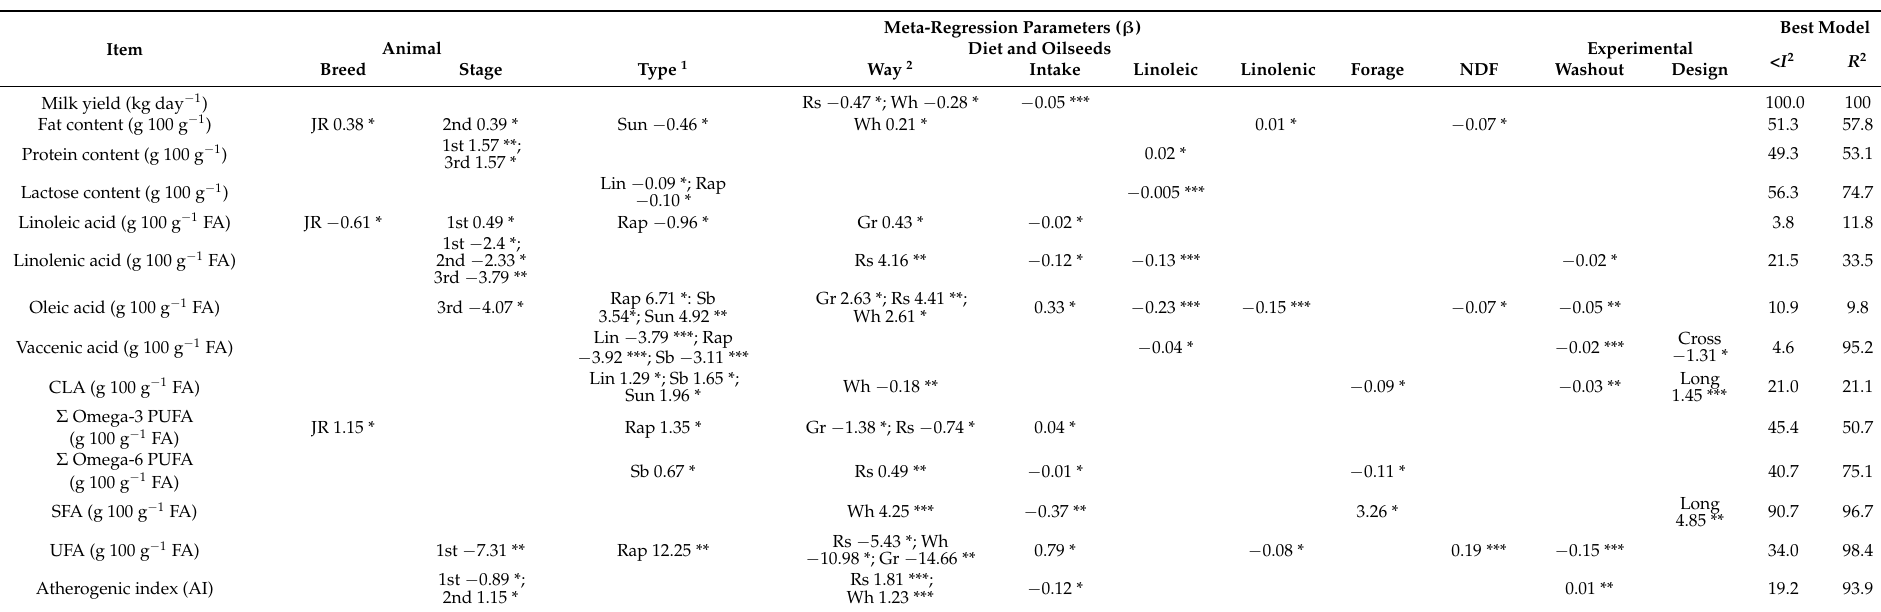
Table 3. Parameters of the meta-regression procedure with the outcome variables and effect size (raw mean difference) between oilseed-supplemented and control treatments of dairy